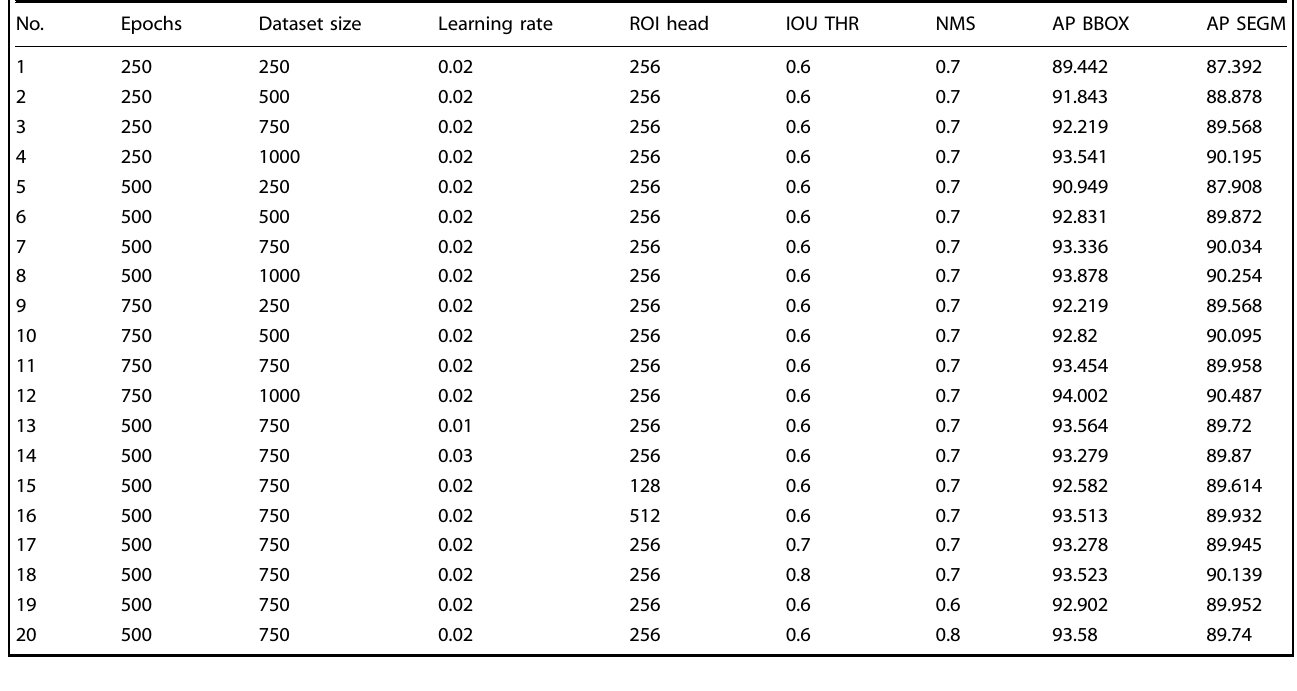
Table 1. Hyperparameter study in the training